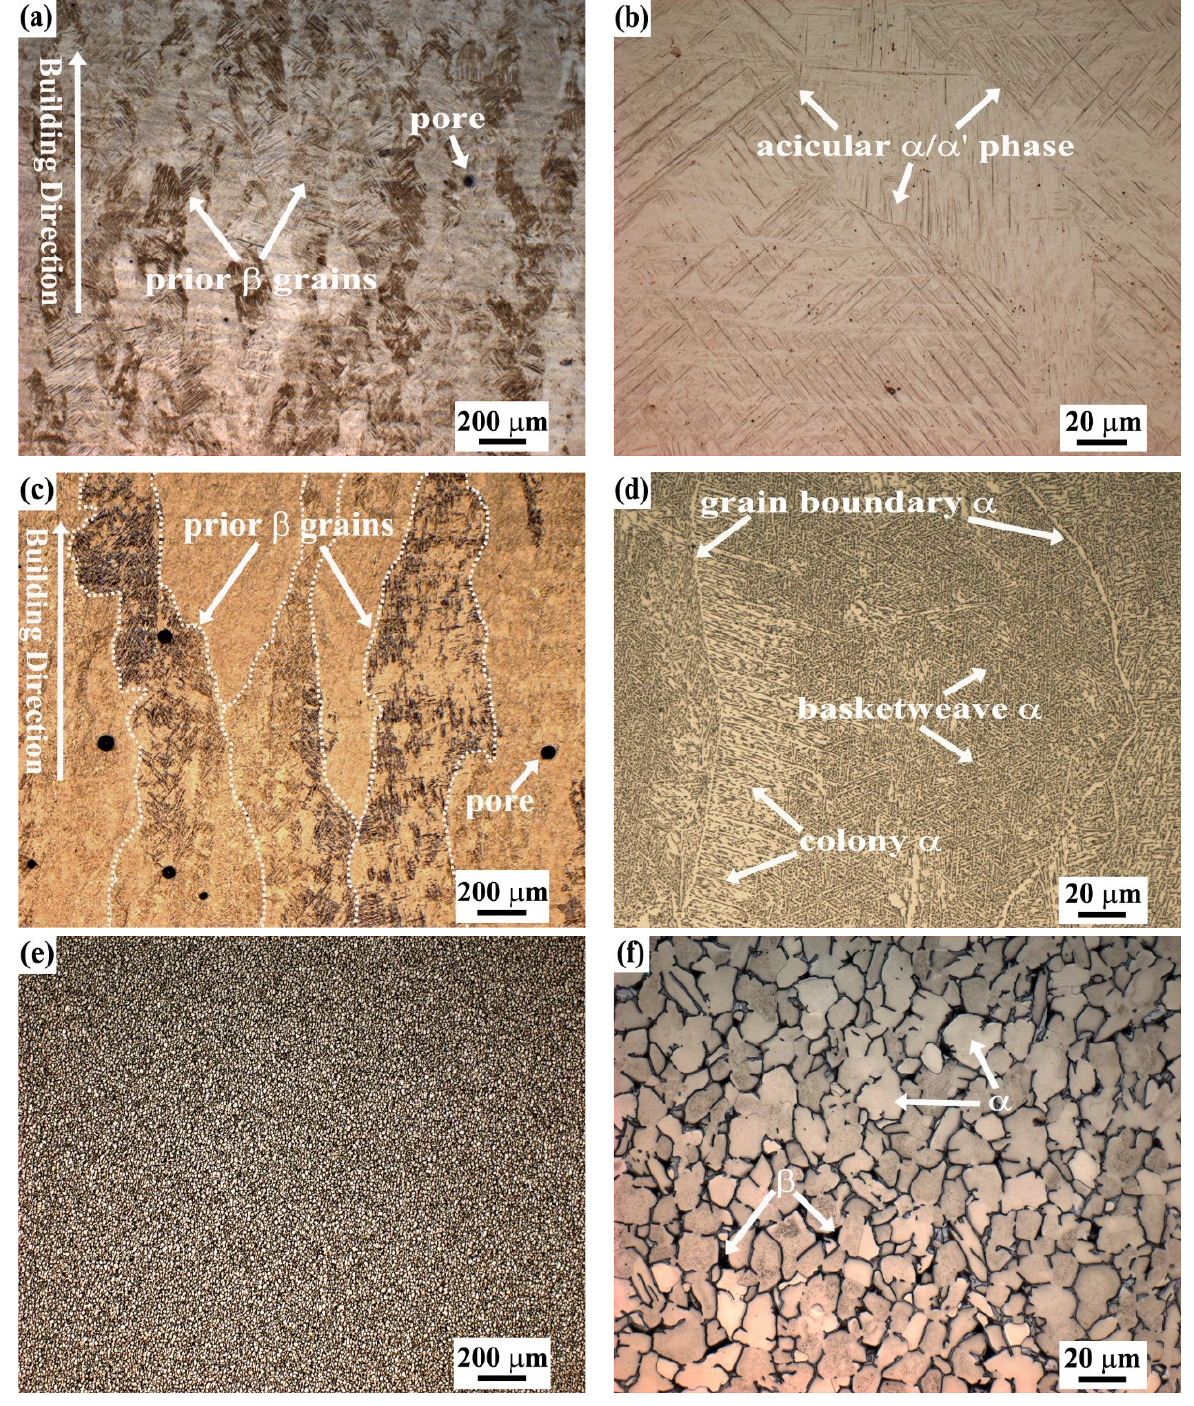
Figure 3. Optical images showing the microstructure of the Ti-6Al-4V alloy samples made with ( a , b ) SLM, ( c , d ) EBM and ( e , f ) ISF.